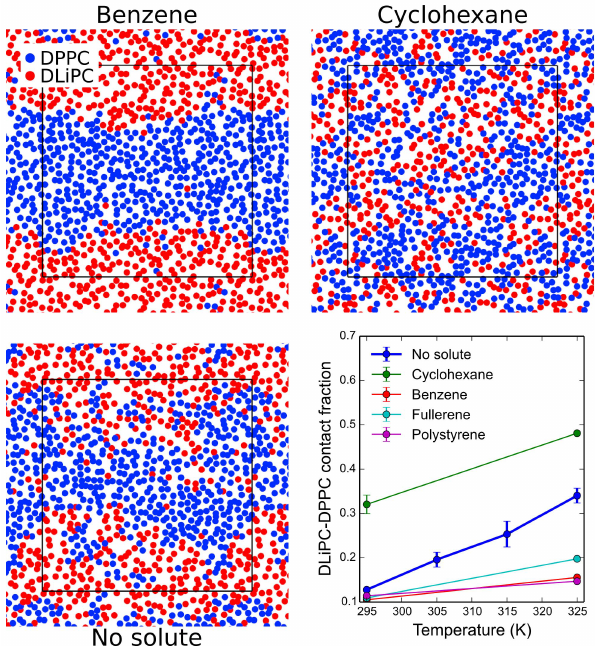
Figure 2. Thermal stabilization of phase separation. Snapshots of a single leaflet from simulations of systems with high concentration of benzene or cyclohexane, and with no solute, at 325 K. Colors are the same as in Fig. 1. Bottom right: DLiPC-DPPC contact fraction as a function of temperature from simulations without solutes and with high concentration of solutes. Thermal stabilization of phase separation is evident for fullerene, benzene, and polystyrene.